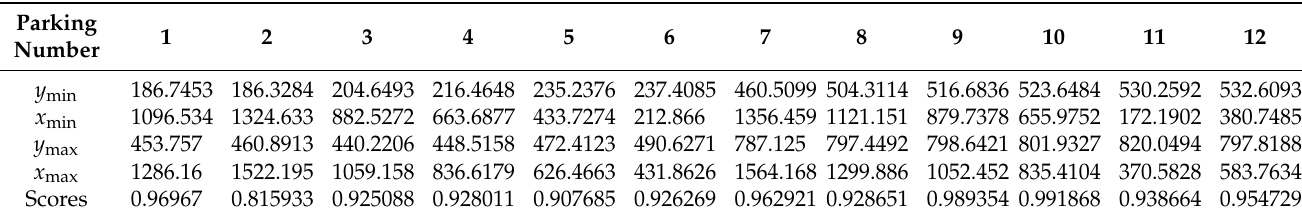
Figure 17. Parking space numbering by the Timsort algorithm.